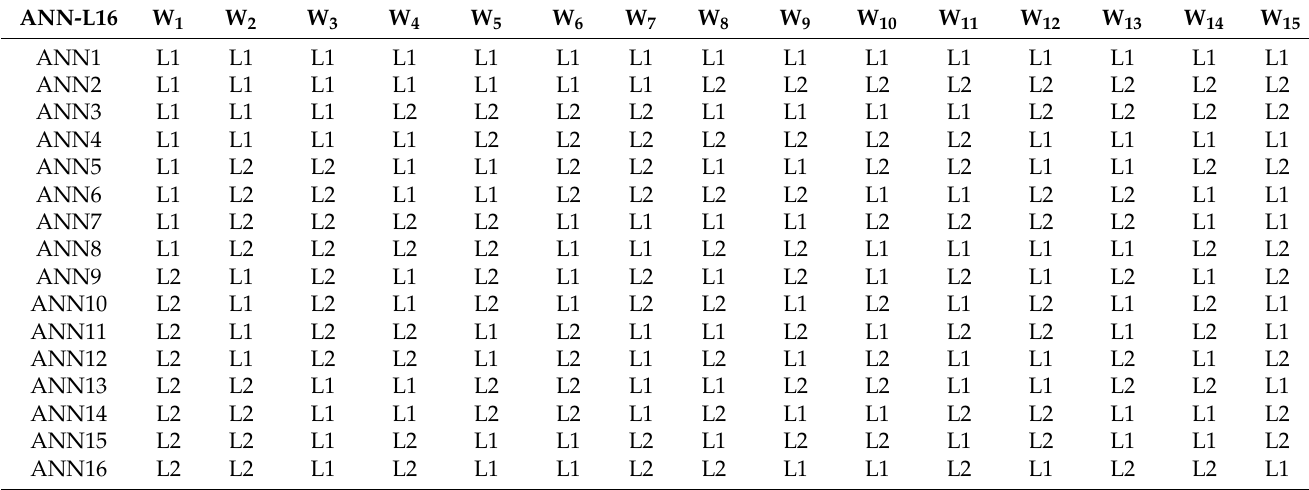
Figure 1. ANN architecture with one hidden layer (ANN-L16). Table 1. Taguchi Orthogonal Array (L16 = 2 15 ).